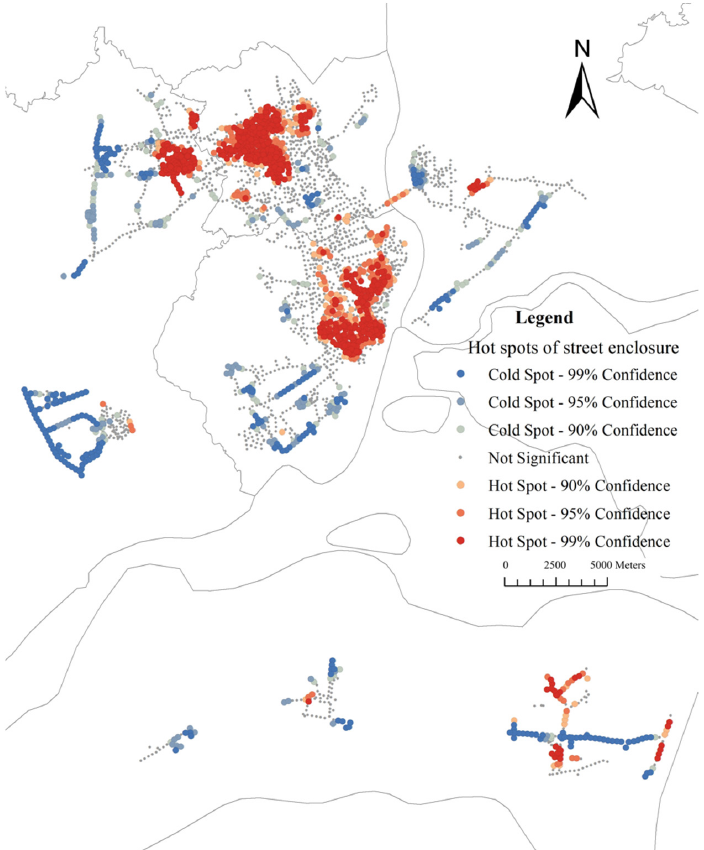
Figure 11. Distribution map of street enclosure hotspot.